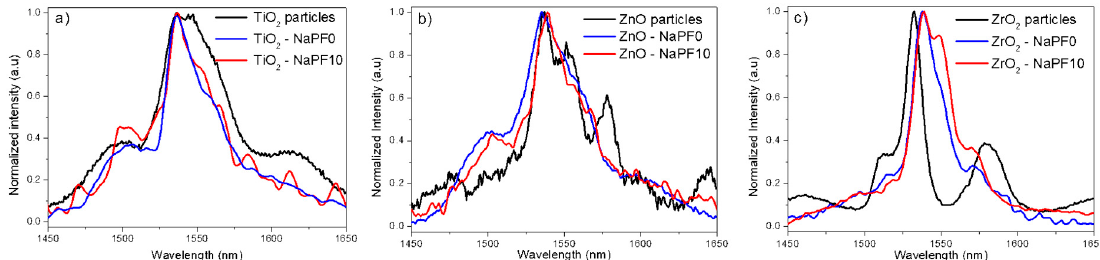
Figure 6. Normalized infrared emission spectra of the Er 2 O 3 -doped TiO 2 ( a ) ZnO ( b ), and ZrO 2 ( c ) particles and of their corresponding particles-containing NaPF0 and NaPF10 glasses with 1.25 wt % of particles.